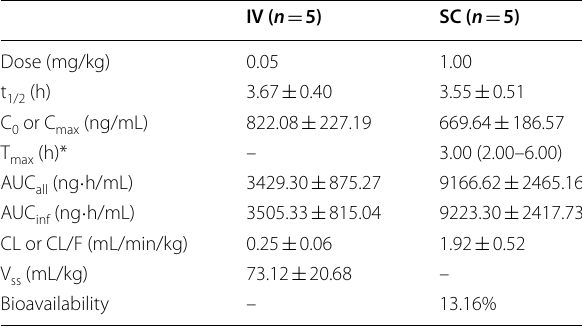
Table 5 Pharmacokinetic parameters of liraglutide following intravenous (IV, 0.05 mg/kg) and subcutaneous (SC, 1 mg/kg) injection in rats (mean SD, n 5) ± =